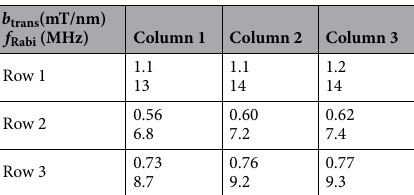
Table 2. b trans and f Rabi at each QD position.